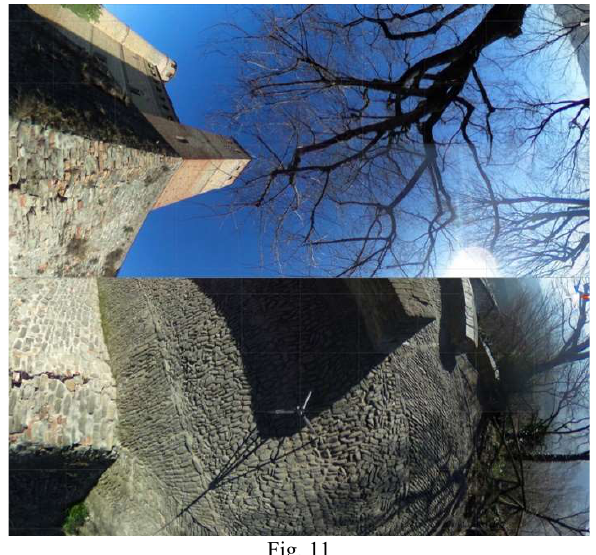
About user interaction within the panorama, Hotspot